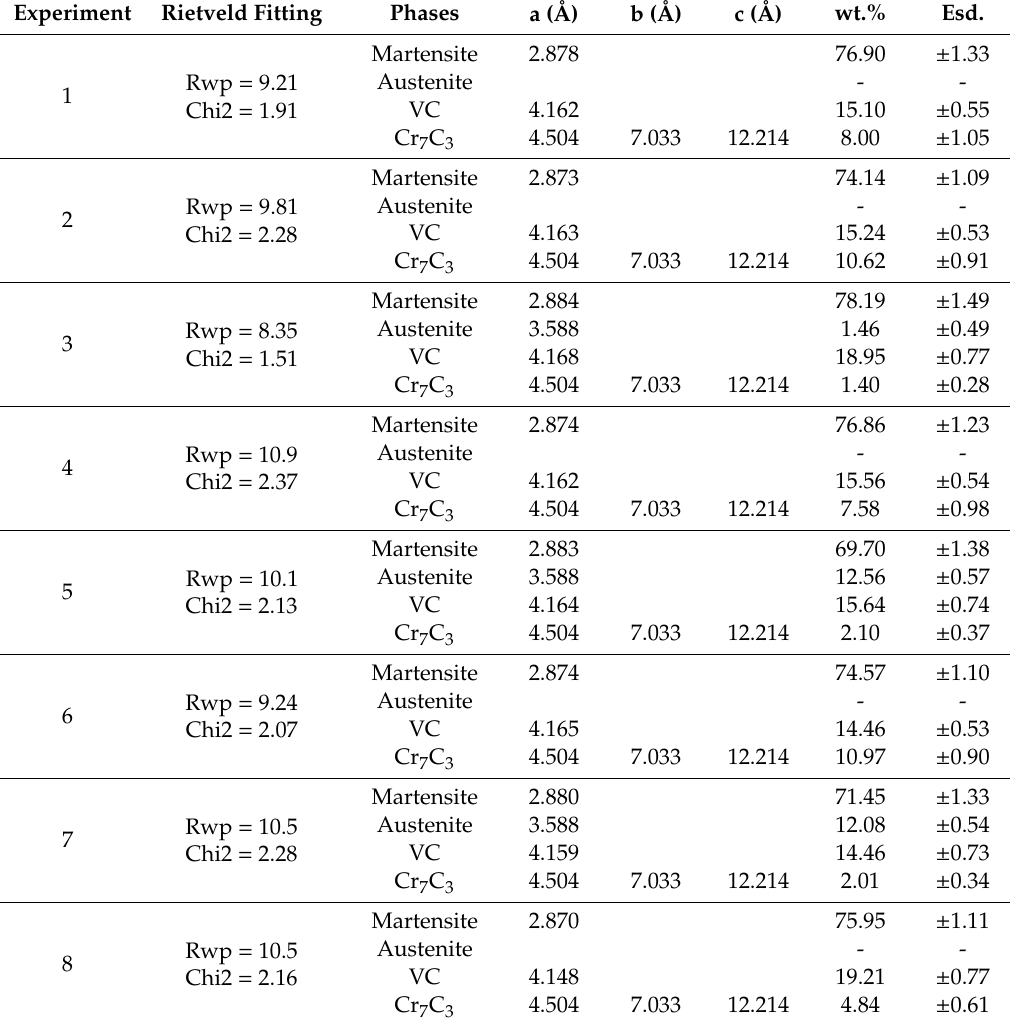
Figure 3. Adjustment using the Rietveld method. The red crosses mark the intensities observed. The blue line shows the intensity calculated according to the structural model. The green line shows the di ff erence between both and the asterisks positions of the di ff erent reflections. Table 4. Microstructural parameters and weight distributions of the precipitated phases. Esd. represents the statistical